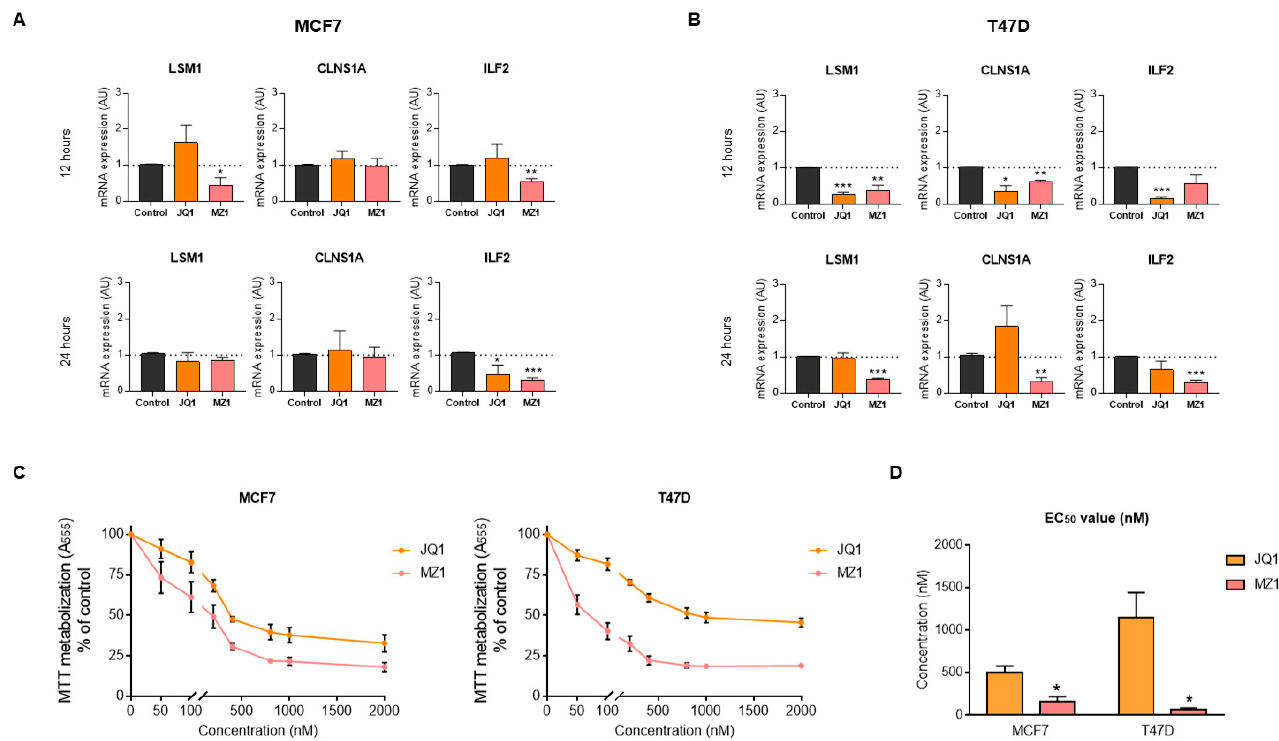
Figure 6. Pharmacological inhibition of splicing-related genes by BET inhibitor and PROTAC. LSM1 , CLNS1A , and ILF2 mRNA expression in MCF7 ( A ) and T47D ( B ) luminal A breast cancer cell lines after 12 h and 24 h JQ1 and MZ1 exposure. Cell viability evaluated by MTT assays for MCF7 (left) and T47D (right) cells treated with increasing doses of JQ1 and MZ1 ( C ). JQ1, MZ1, and EC50 doses in luminal A cell lines ( D ). * p < 0.05; ** p < 0.01; *** p < 0.001.